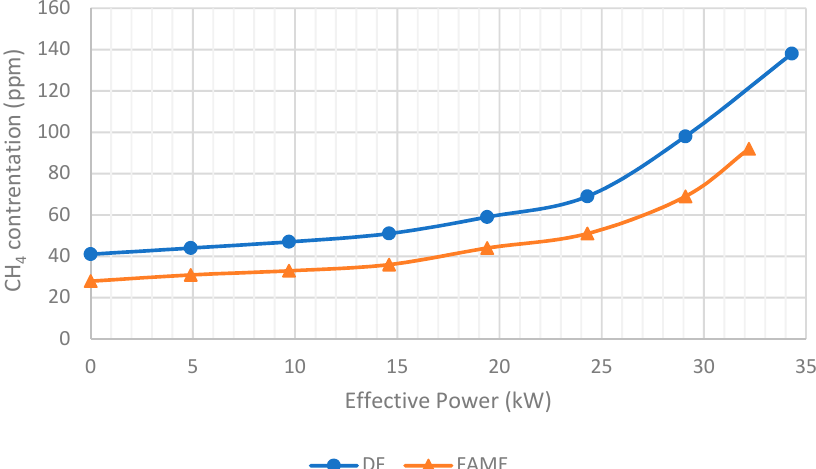
Figure 11. CH 4 emission level in the exhaust as a function of the effective power of the S-4003 engine, at an engine speed of 2200 rpm.